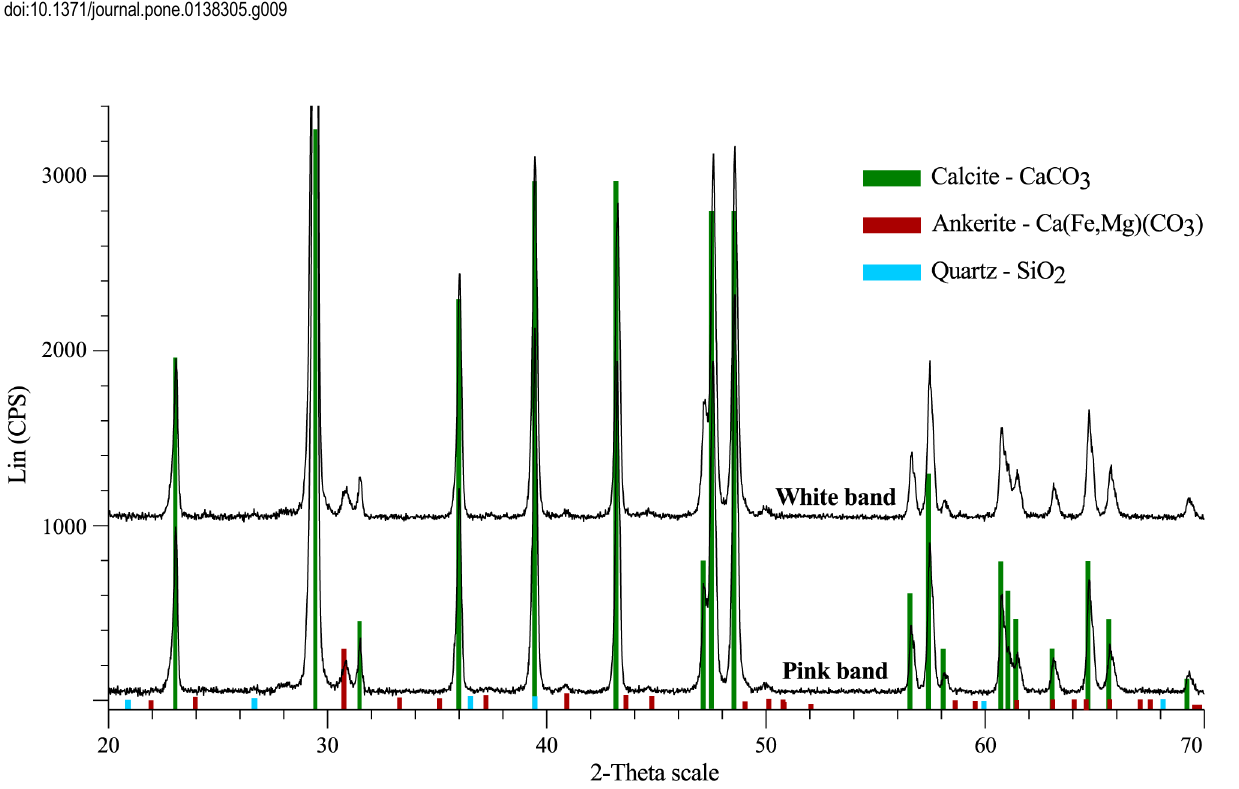
Fig 9. 2D X-ray radiograph of UOM-232 (a) showing differences in calcite density in the different visible bands (b). Letters indicate equivalent bands on both images. The white bands are lower density than the pink bands.